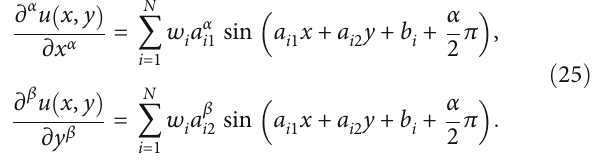
Figure 2: Neural network